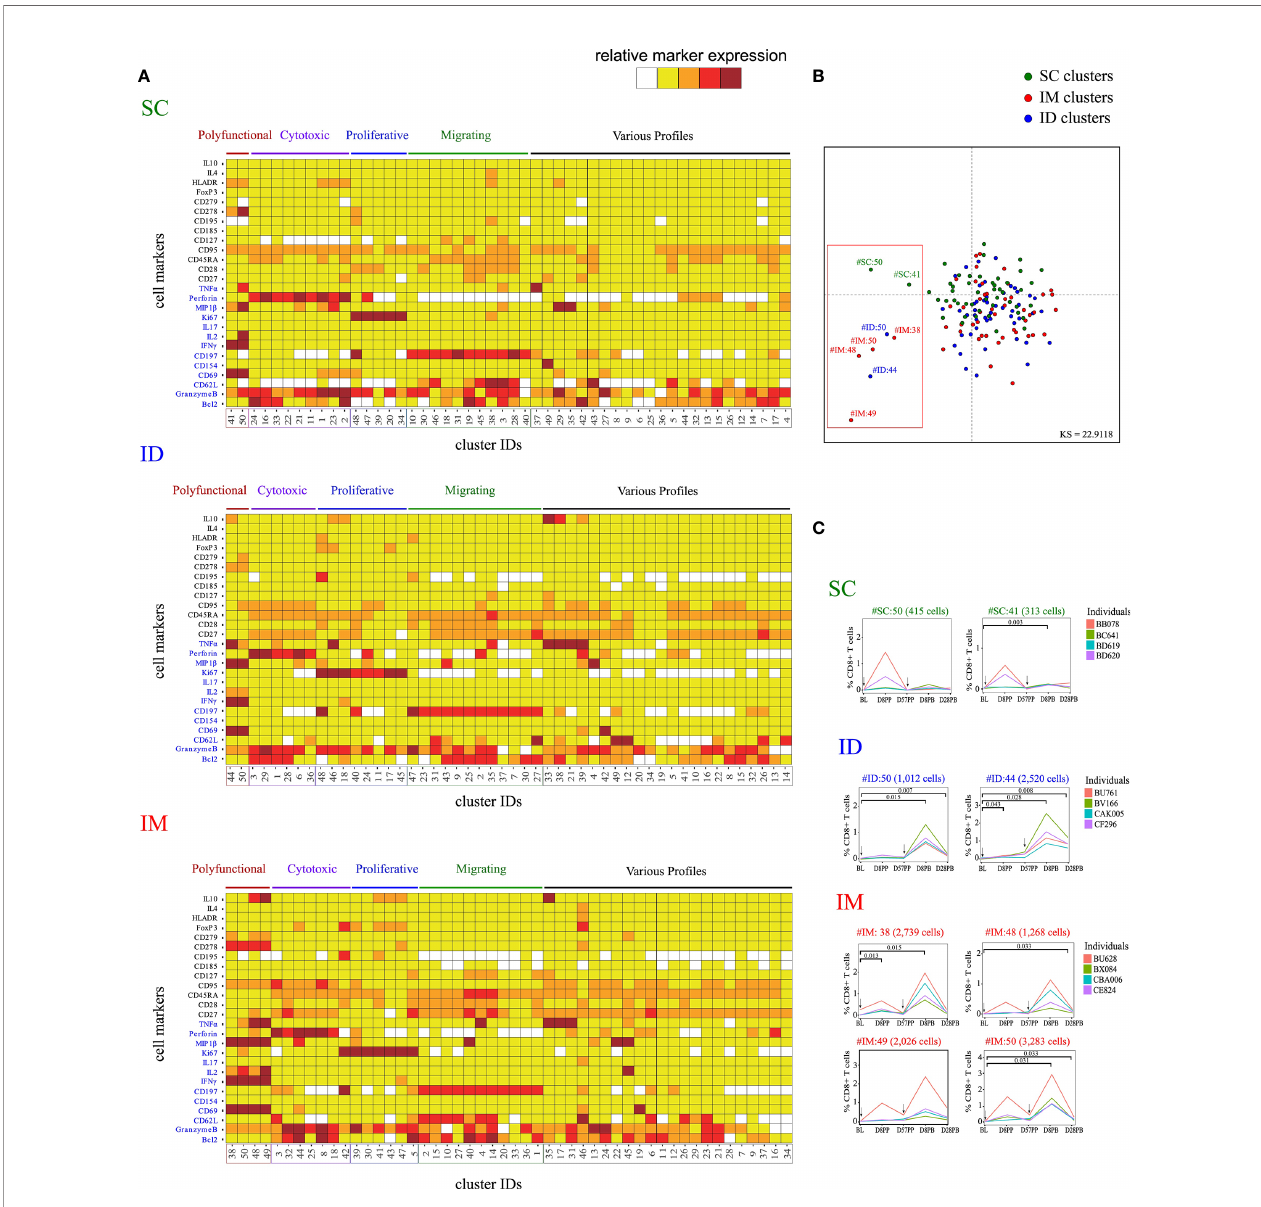
FIGURE 2 | Characterization of the impact of the SC/ID/IM routes on CD8 + T-cell phenotypic cluster diversity by mass cytometry. (A) Categorical marker expression heatmap representing the phenotypes of CD8 + T cells for each administration route. SPADE analysis was performed for each administration route based on the entire cell set according to the gating strategy described in Figure S1 . Markers in blue were used as clustering markers in the SPADE analyses. Cell clusters were organized into families by hierarchical clustering. The fi ve-tiered color scale, from white to deep red, represents relative marker expression. (B) Two-dimensional MDS representation showing the phenotypic differences and similarities between cell clusters identi fi ed by each SPADE analysis. Phenotypic similarities were quanti fi ed based on the mean signal intensity of the 13 SPADE clustering markers. Red square indicate the eight singular cell cluster (C) Charts showing changes in the percentage of CD8 + T cells over time for the selected marginal clusters. Black arrows indicate the days of vaccine injection. BL, baseline; D, day; PP, post-prime; PB,